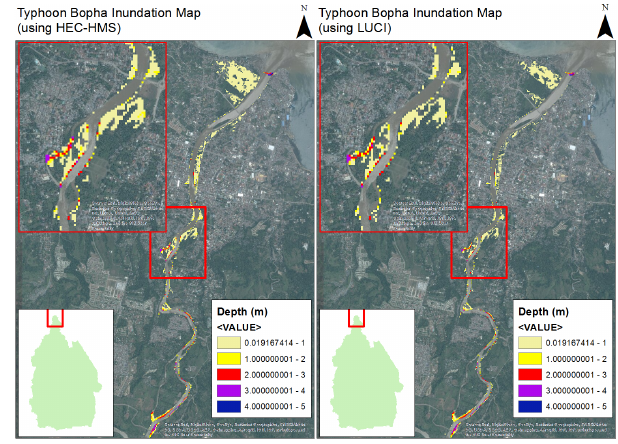
Figure 6. Inundation maps produced in HEC-RAS using the HEC- HMS hydrograph and the LUCI hydrograph, with the inset showing the flood water encroaching on the river banks and buildings.